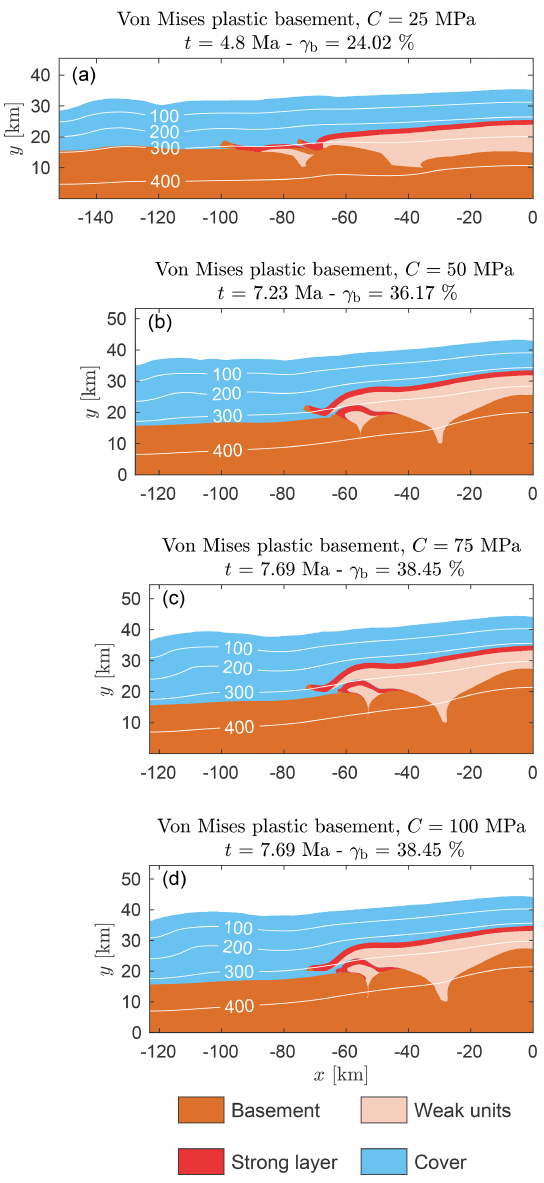
Figure 8. The final geometry and temperature fields of three simu- lations with different von Mises yield criteria (see figure titles). The simulation with C = 25MPa has been terminated earlier, as the re- sults (the sedimentary units are bulldozing off huge pieces of the crystalline basement) are totally different from geological observa-